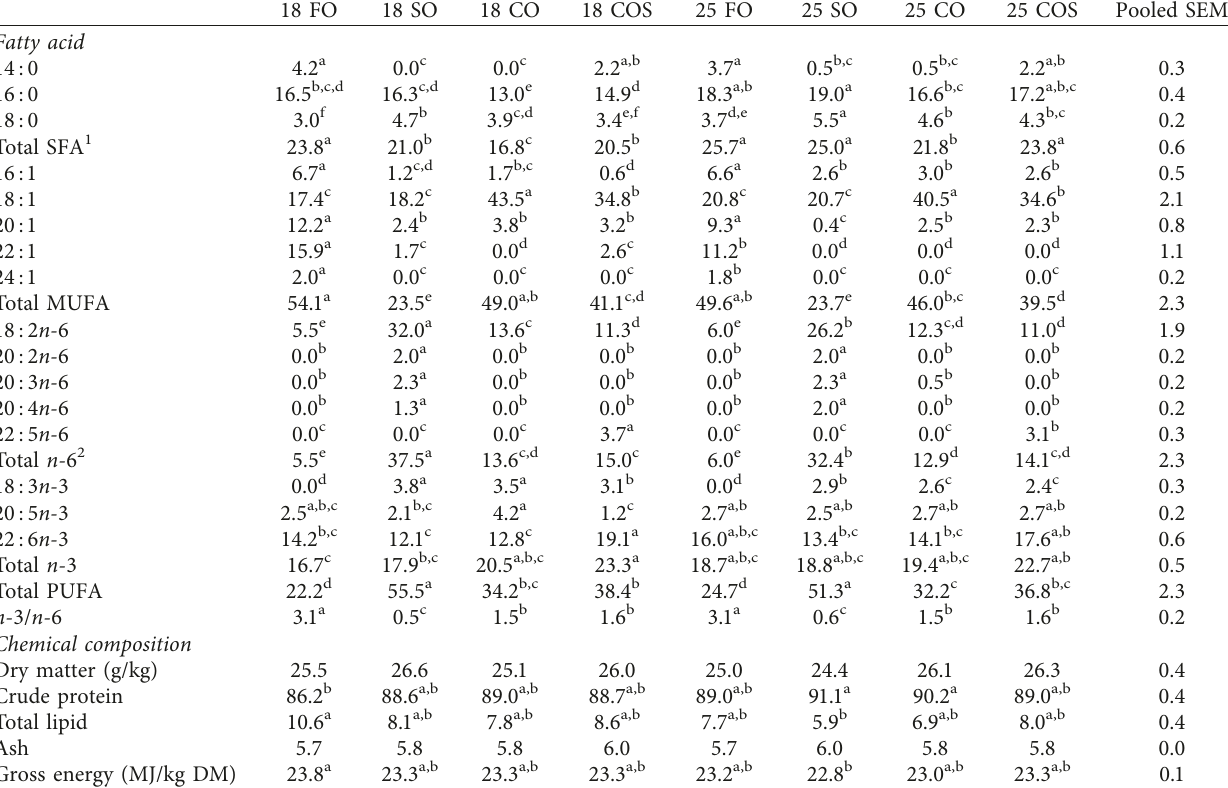
Table 4: Effects of fish oil replacement with soybean oil, canola oil, and a blend of canola and Schizochytrium sp. biomass on fillet composition (g/kg DM) and fatty acid profile (% of total fatty acids) after growth